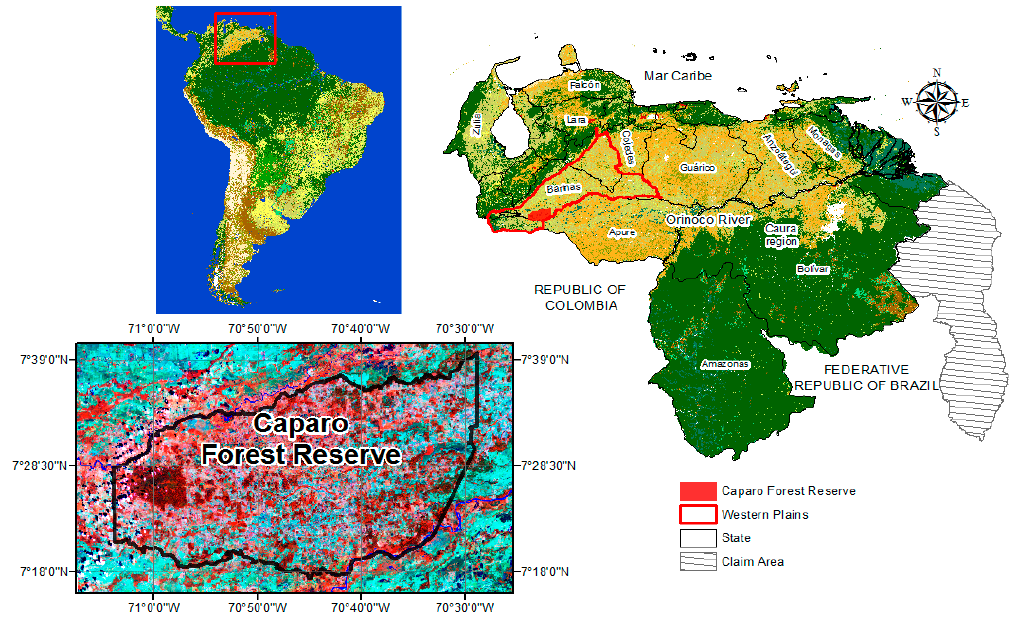
Figure 1. Location of the Caparo Forest Reserve (CFR), highlighting South America, Venezuela and the Western Plains bioregion on the map Globcover map of 2009 [54]. The CFR is shown in a Landsat Image of 2011 (RGB: 453) on bottom left corner. Dark-red areas correspond to the forests, while light red to crops and grasses, and cyan to bare soils.